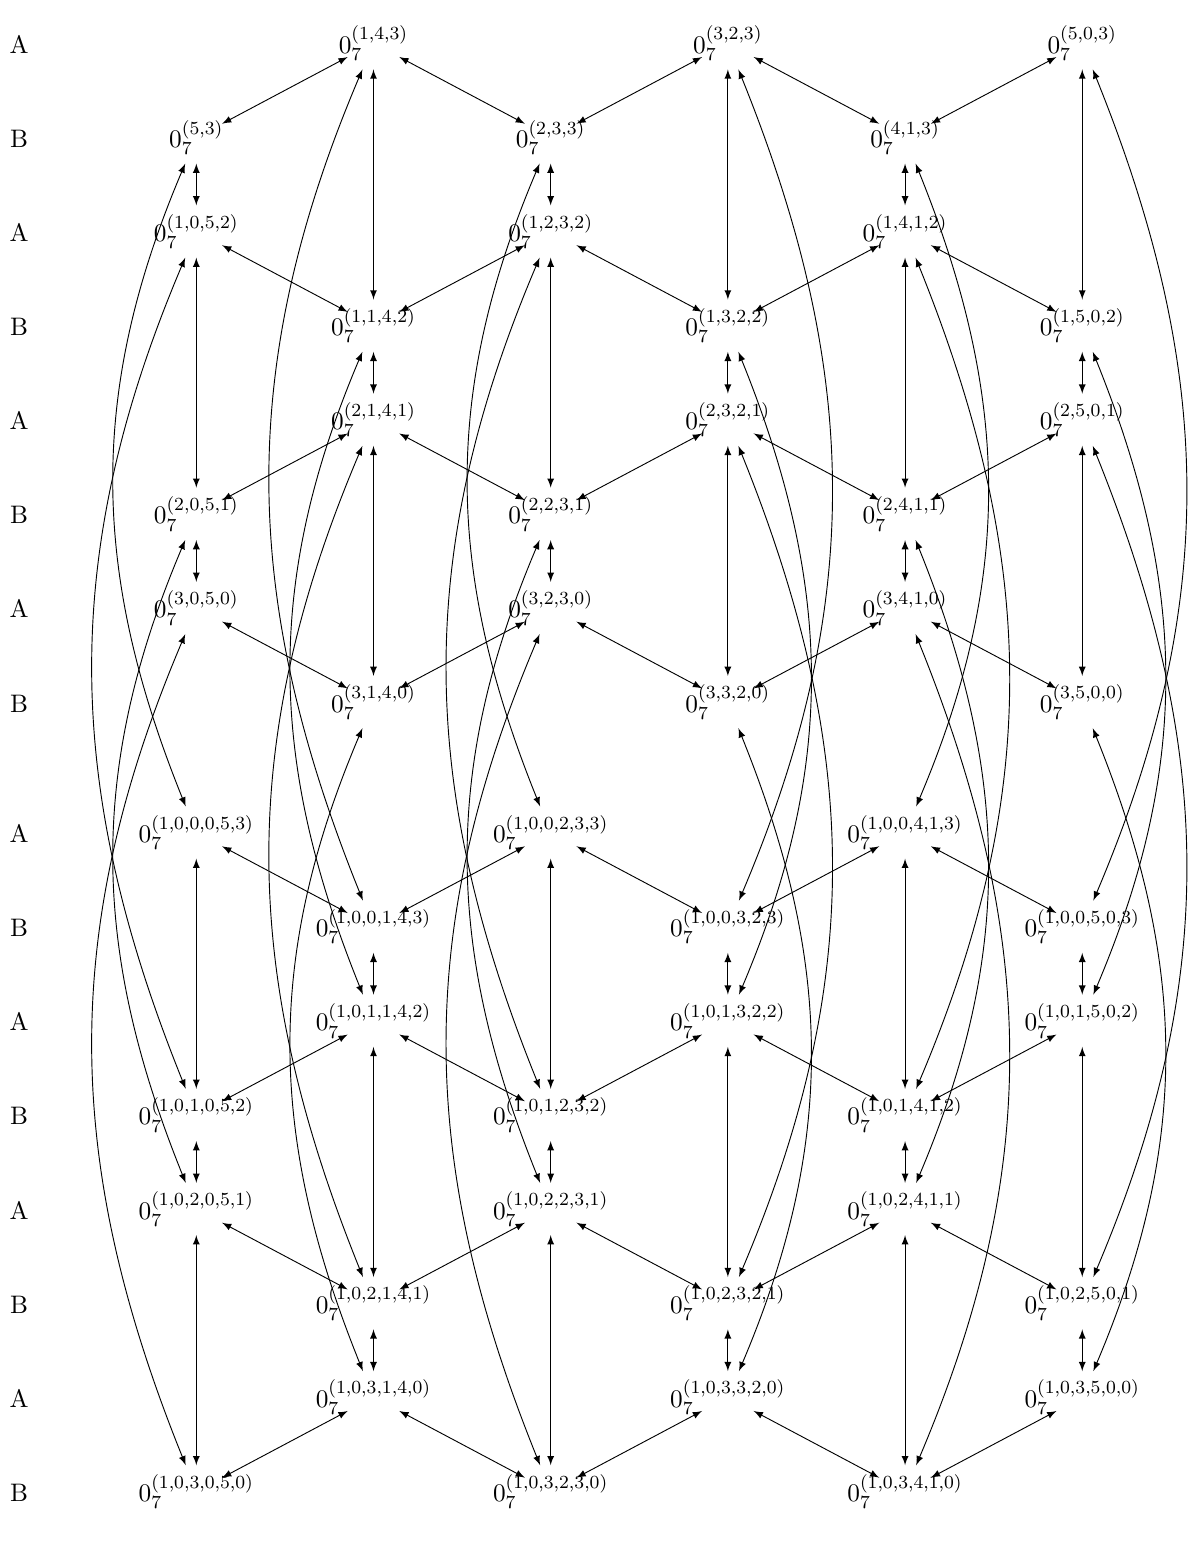
Figure 15 . The T-duality orbit of the 0 (5 ; 3)